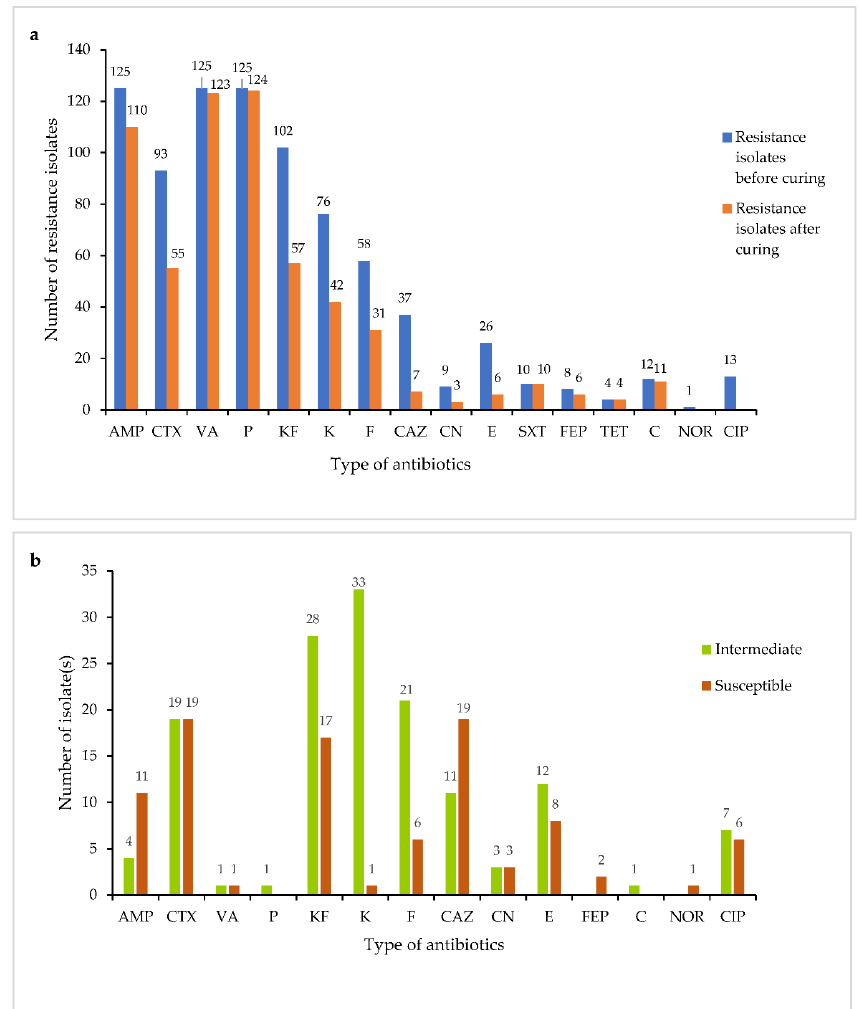
Figure 4. ( a ) Antibiotic resistance profiles of Vibrio spp. before and after plasmid curing. The Y-axis represents the number of isolates resistant to the tested antibiotics, while the X-axis represents types of antibiotics ( b ) Number of isolates that changed to intermediate and susceptible from resistance after plasmid curing. AMP: Ampicillin, CTX: Cefotaxime, VA: Vancomycin, P: Penicillin G, KF: Cephalothin, K: Kanamycin, CAZ: Ceftazidime, F: Nitrofurantoin, CN: Gentamicin, E: Erythromy- cin, SXT: Sulfomethiozole-trimethoprim, FEP: Cefepime, TET: Tetracycline, C: Chloramphenicol, NOR: Norfloxacin, CIP: Ciprofloxacin